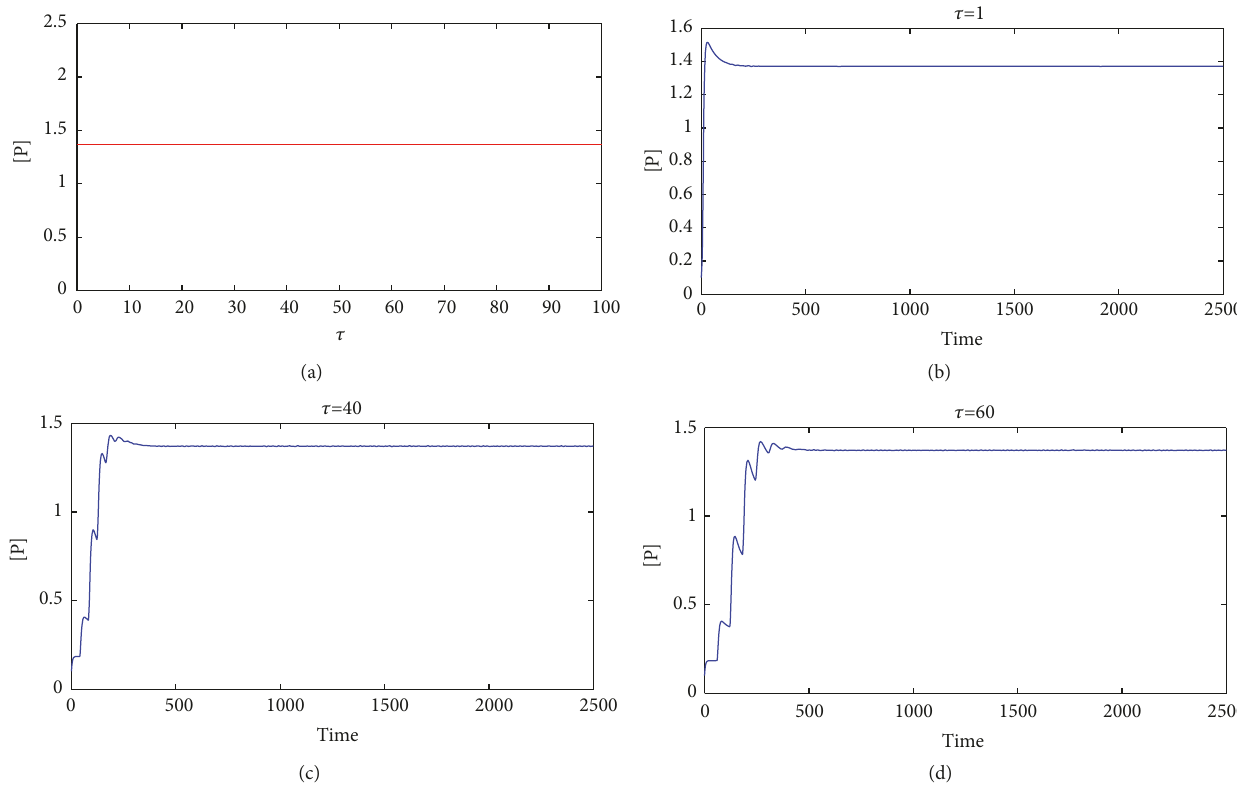
Figure 3: (a) Bifurcation diagram of [P] with time delay 𝜏 as the bifurcating parameter when fixing the negative feedback strength Γ 2 = 0.01 . (b),(c),and(d)aretimecoursesdiagramof [𝑃] fortheparameter 𝜏 =1(b),40(c),and60(d),respectively.Initialconditions: 𝑃(0) = 0.1, 𝑀(0) = 0.1 .